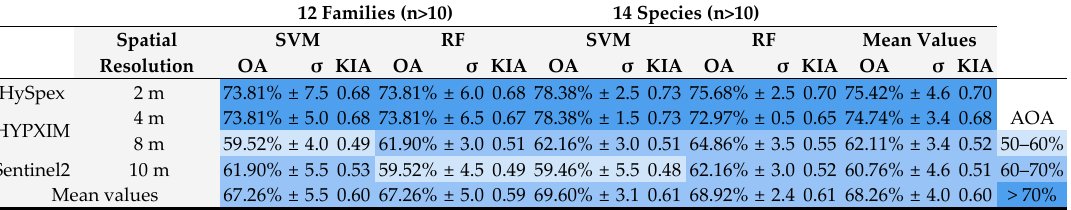
Table 6. Urban tree diversity classification results obtained using the 2-folds learning method and Table 7. Classifications mean results by spatial resolution and dimension reductions using the 2-folds applied on reduced MNF image datasets, with SVM and RF classifiers according to subsets exhibiting at learning method. Remote Sens. 2019 , 11 , x FOR PEER least 10 individuals per class.